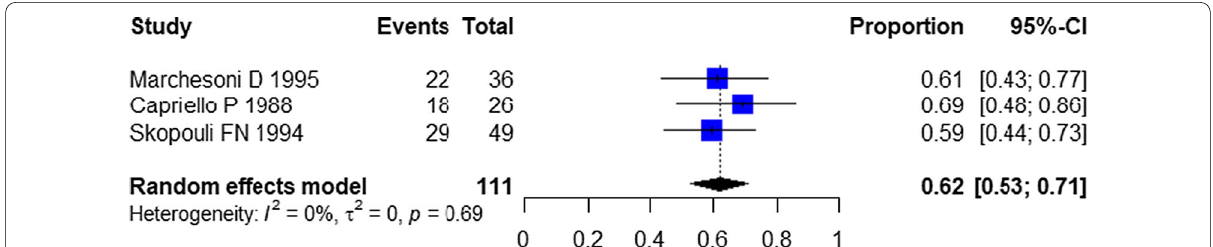
Fig. 3 Meta‑analysis of the prevalence of dyspareunia in women with Sjogren’s